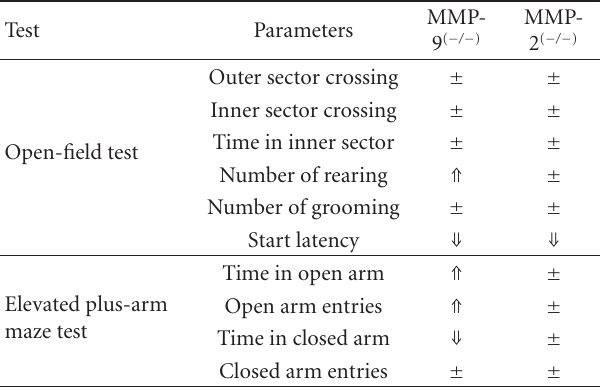
Table 1: Summary of behavioral changes related to